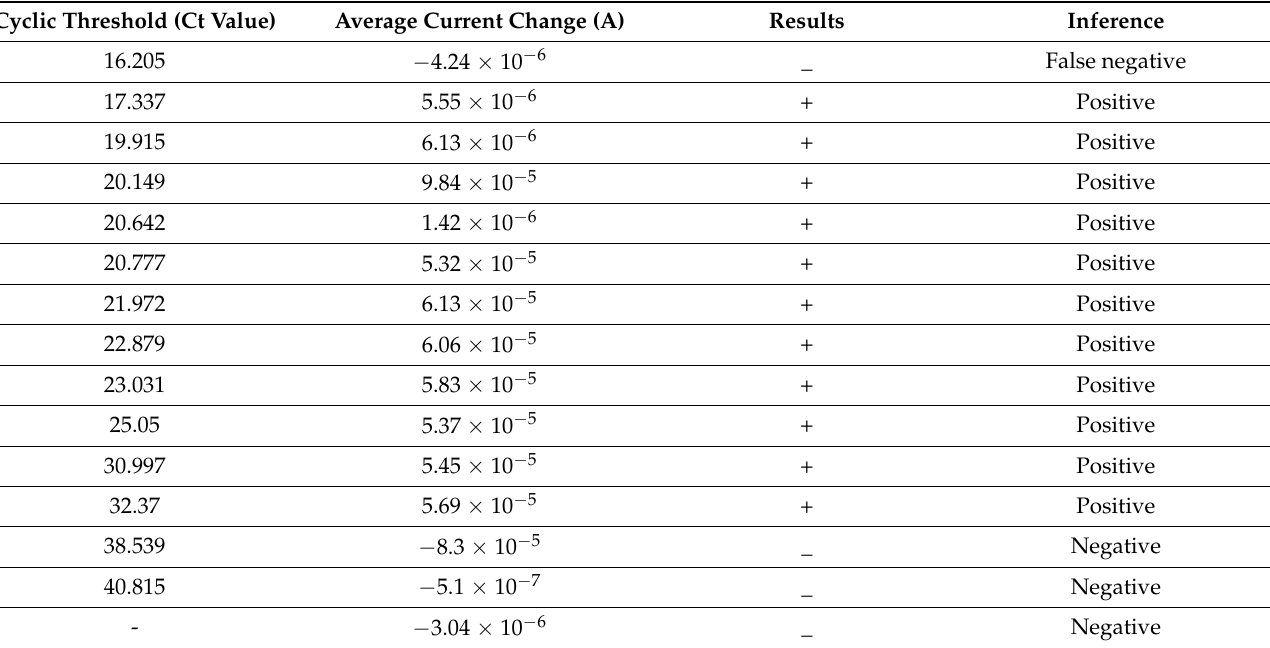
Table 2. Validation of electrochemical sensor for clinical samples of SARS-CoV-2 viral mRNA. Cyclic Threshold (Ct Value) Average Current Change (A) Results